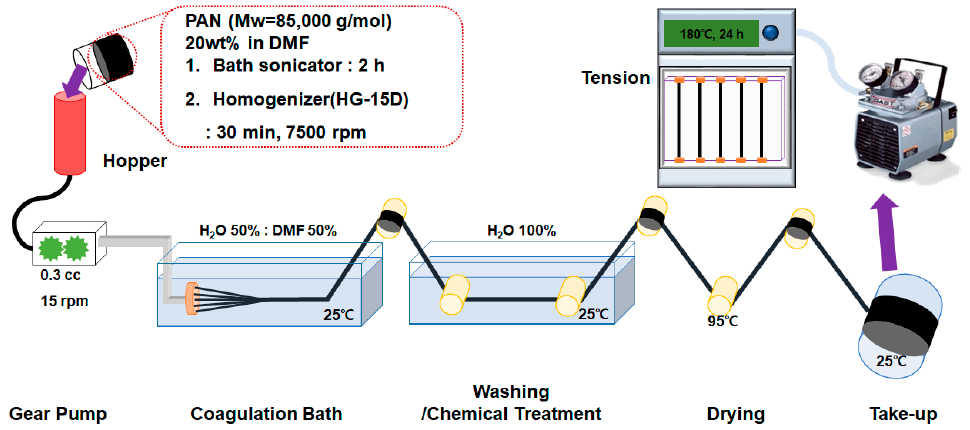
Figure 2. Schematic of the manufacturing processes for conductive fibers.